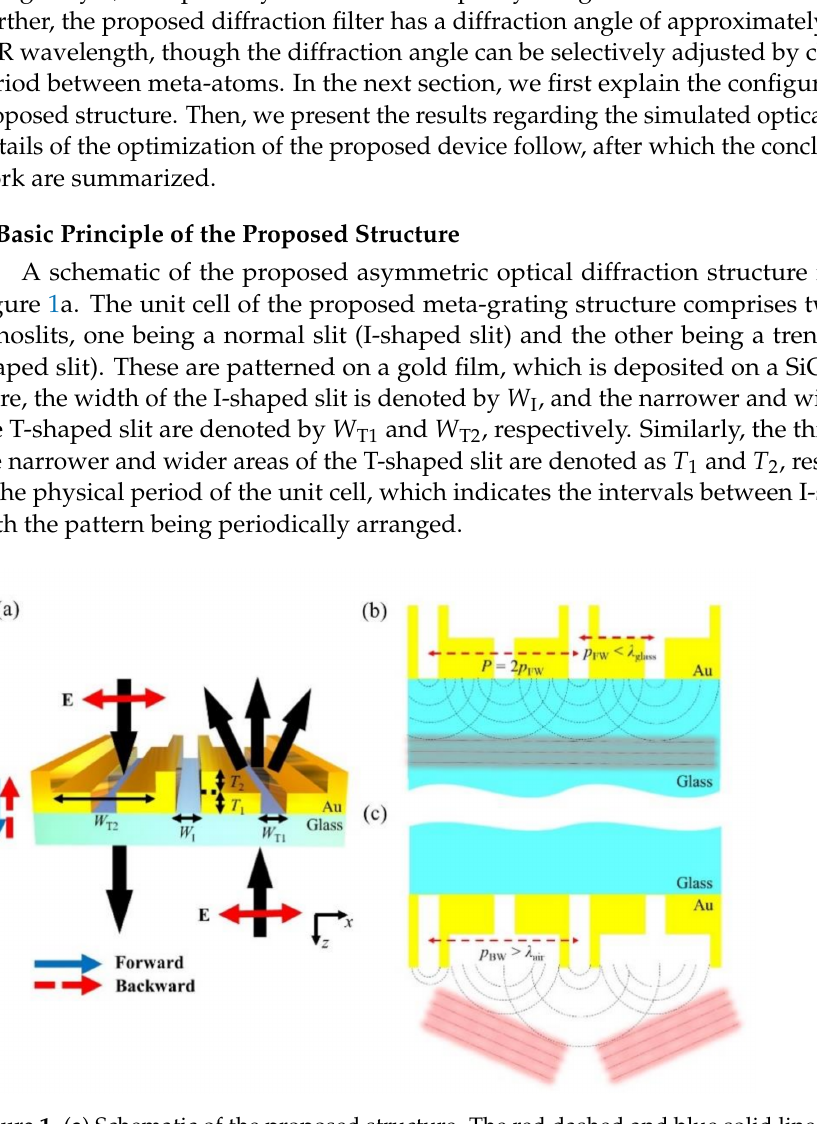
Figure 1. ( a ) Schematic of the proposed structure. The red dashed and blue solid lines indicate the light illumination directions with and without diffraction, respectively. ( b , c ) Schematic explaining the asymmetric diffraction of the proposed structure in the ( b ) forward and ( c ) backward directions. The key concept behind obtaining asymmetric optical diffraction according to the illumination ( p FW and p BW , respectively) at the output port of the proposed